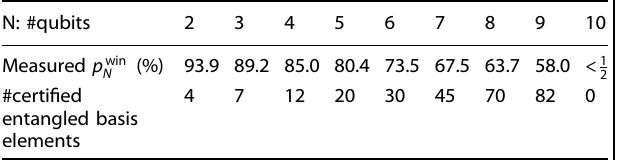
Table 1. Results for N -qubit communication network experiments on the ibmq_montreal quantum computer.